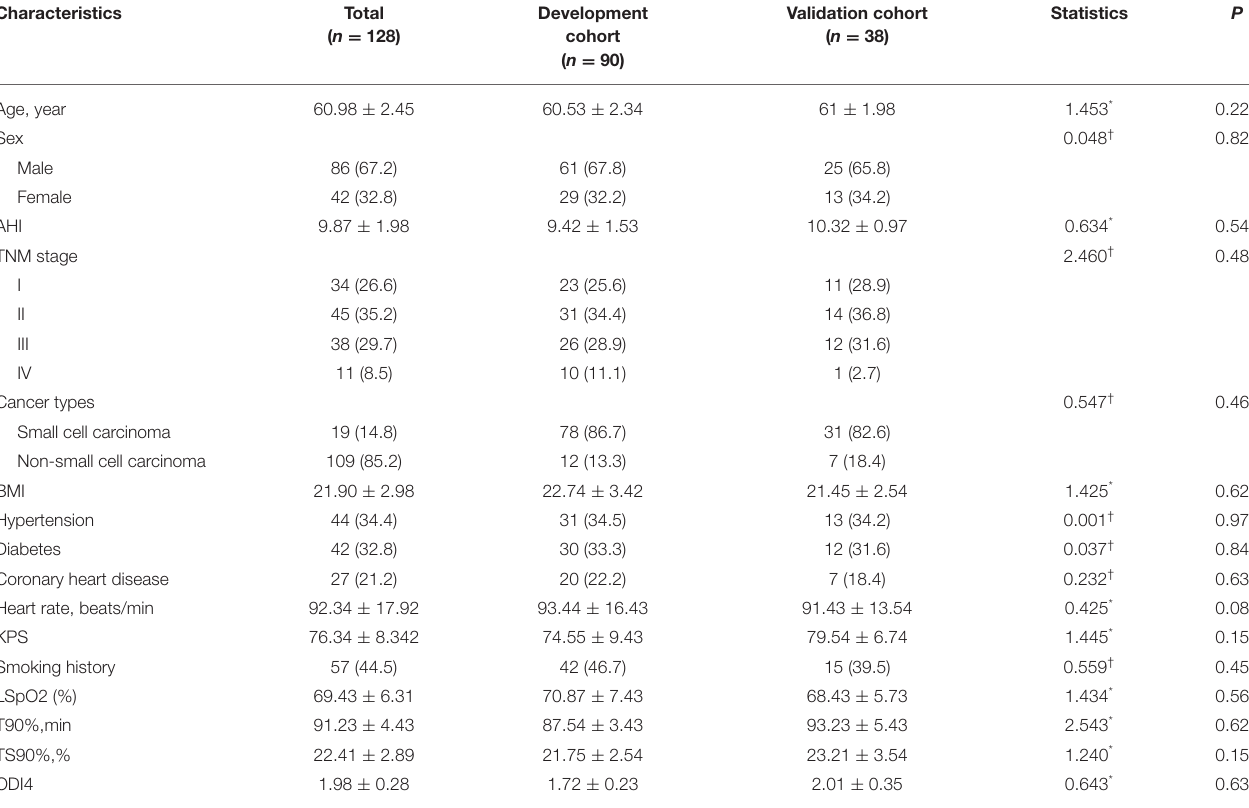
TABLE 2 | Baseline clinical features of lung cancer patients with OSA [Mean ± SD/No (%)]. Characteristics